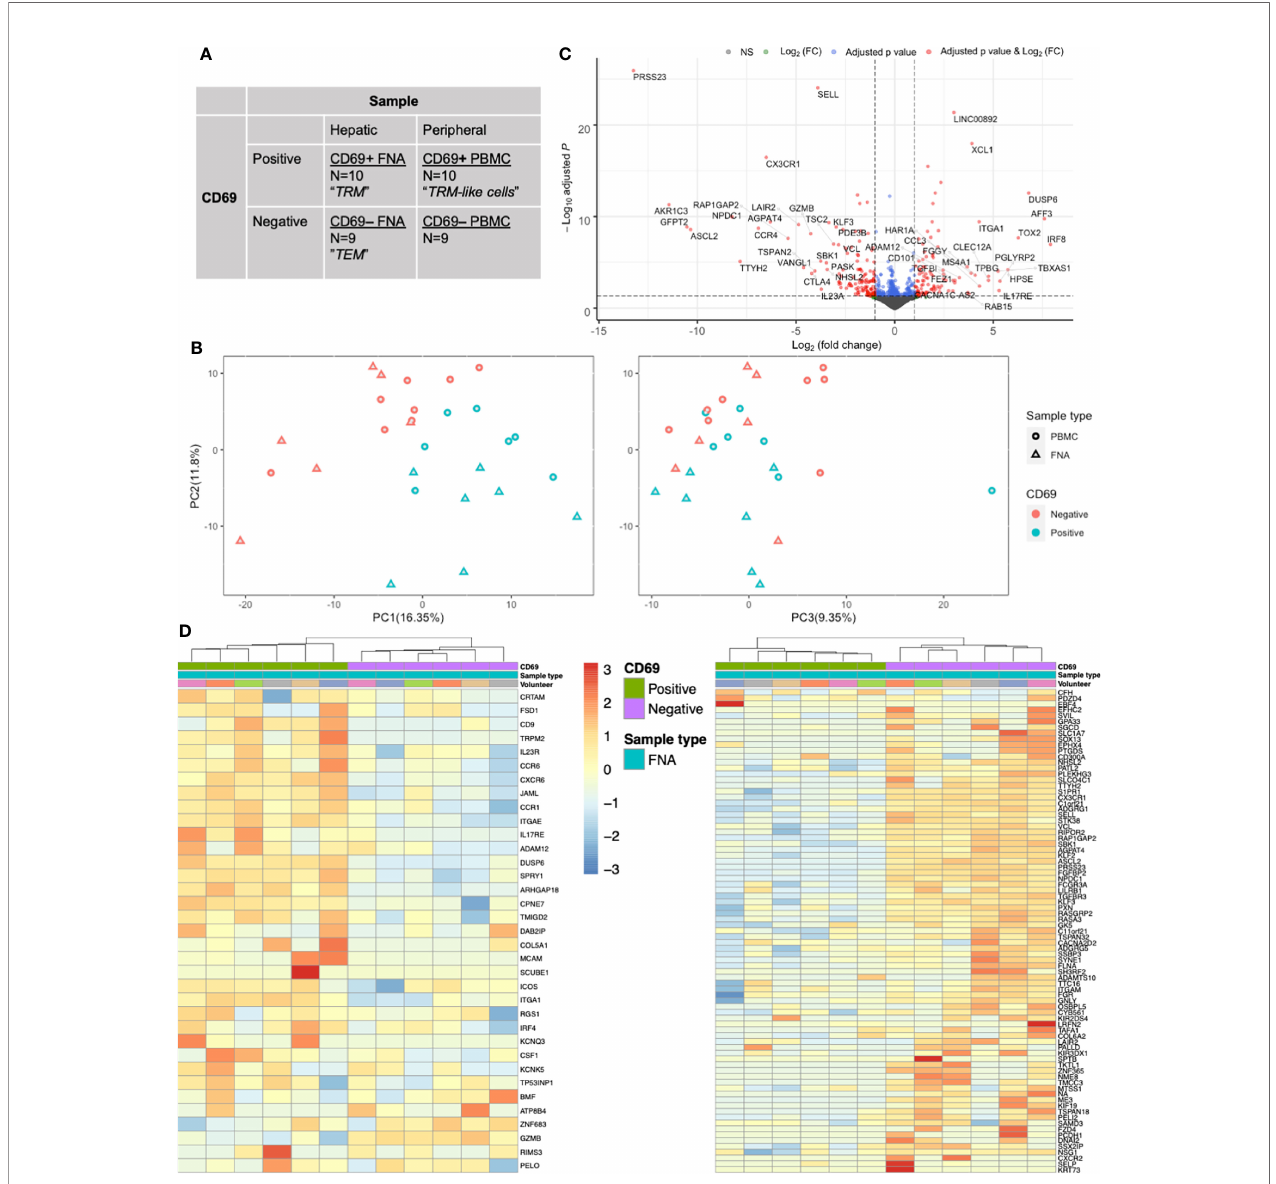
FIGURE 2 | CD69 status is a major driver of transcriptional differences in memory CD8+ T cells as assessed by mini-bulk RNA-seq. (A) Mini-bulk RNA-seq experimental design. Each category was composed of N number of 100-cell samples pre-gated on live single CD20- CD45+ CD3+ CD4- CD8+ CD45RA- cells sequenced in bulk by the SmartSeq2 protocol. Two volunteers ’ samples and one FNA paired (CD69+ and CD69-) samples were removed during QC. Non- normalised counts were input to DESeq2 and samples were paired according to volunteer and sample type. Differential expression analyses used a generalised linear model where counts were modelled using a negative binomial distribution. The Wald test was the default used for hypothesis testing when comparing gene expression between two sets of paired variables. See Figure 1A for sampling work fl ow. (B) PCA plots based on the 500 most variable genes by mini-bulk RNA sequencing. Plots of the fi rst three PC, coloured according to CD69 status and sample type of the sequenced cells. Separation of CD69+ and CD69- cells was a composite of PC1 and PC2. PC3 does not distinguish CD69 status. Twenty-eight samples were analysed. (C) Volcano plot of up- and down-regulated genes between paired FNA CD69+ samples and CD69- samples. The top 50 up- and down-regulated genes have been annotated. Positive log(FC) values indicate greater gene expression in CD69+ samples, compared to CD69- samples. Negative log(FC) values indicate greater gene expression in CD69- samples. Differential expression of the 12,515 genes was tested for signi fi cance using the Wald test. P values were adjusted using the Benjamini-Hochberg (false discovery rate) correction. (D) Gene heatmap of FNA samples using the core TRM cell transcriptional signature described by Kumar et al. Left, heatmap of genes that are upregulated in the CD8+ Kumar et al. core transcriptional signature. Right, heatmap of genes that are downregulated in the CD8+ Kumar et al. core transcriptional signature. Columns are clustered based on Spearman ’ s correlation of rlog normalised count values. Rows are clustered according to Pearson correlation of the rlog normalised gene counts. Gene count values are centred and scaled across rows. FACS, fl uorescence-assisted cell sorting; FC, fold change; FNA, fi ne needle aspirate; PBMC, peripheral blood mononuclear cells; PC, principal component; PCA, principal component analysis; QC, quality control; TEM, effector memory T cell; TRM, tissue-resident memory T